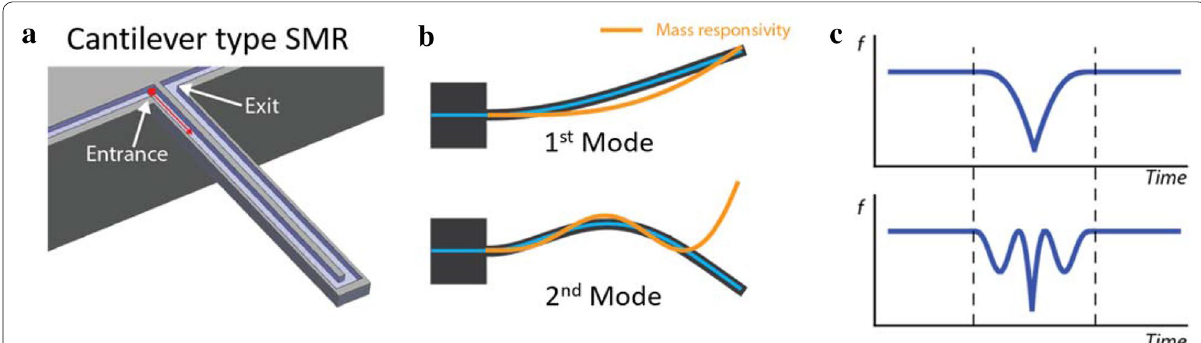
Fig. 1 Mode characteristics and frequency responses of cantilever (clamped-free) type suspended microchannel resonators (SMRs) with a traveling particle. a Schematic of a cantilever-type SMR with its top cover removed. b Mode shape and associated mass responsivity of the resonance frequency of the first and second flexural bending modes. c Variation of the first and second mode resonance frequencies while a particle travels through the integrated